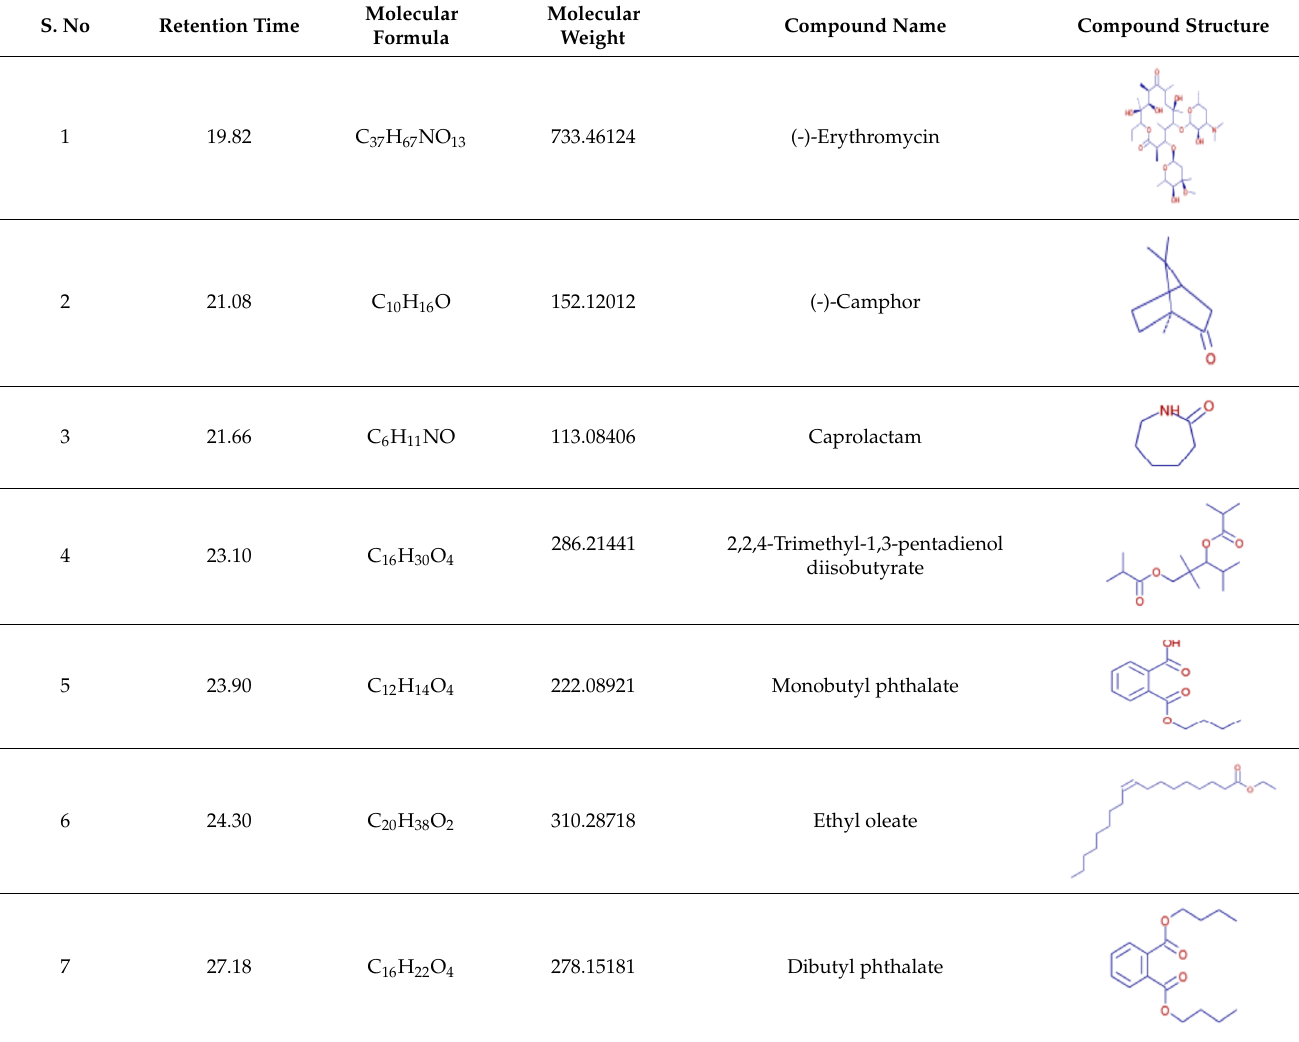
Table 6. The major functional group was identified from M. anisopliae ethyl acetate crude extract using FT-IR analysis.